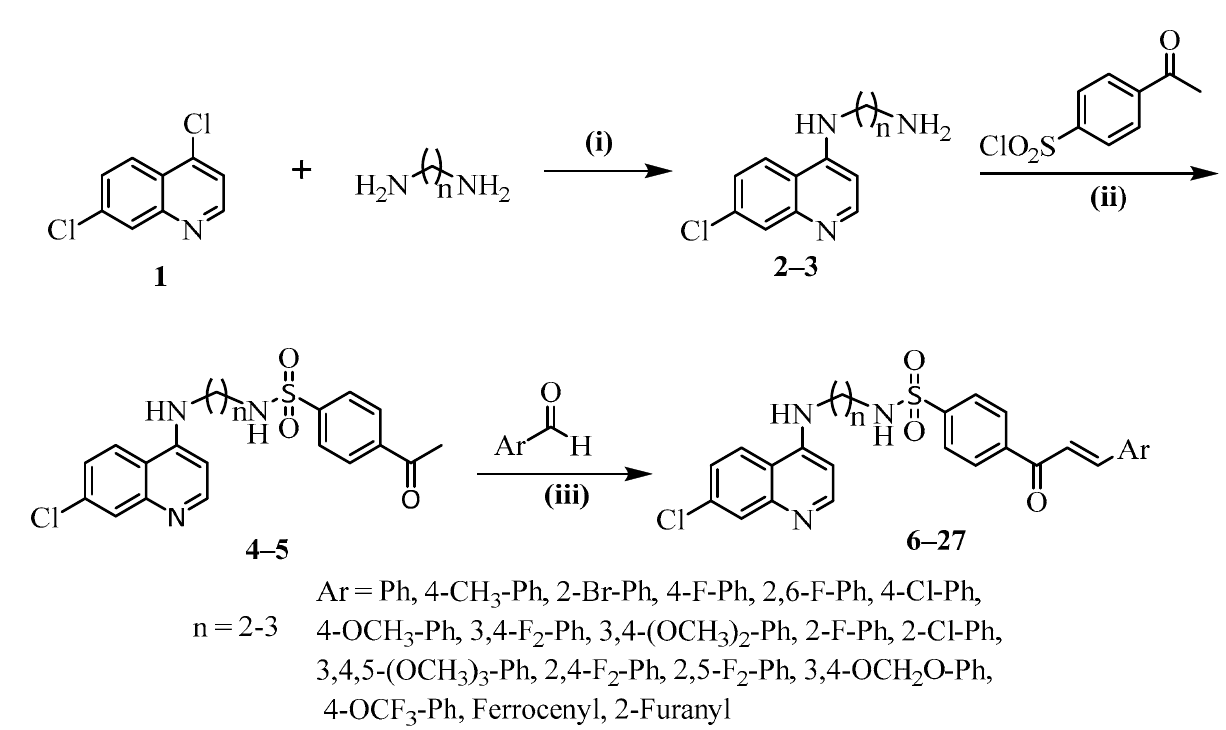
Molecules 2021 , 26 , x FOR PEER REVIEW